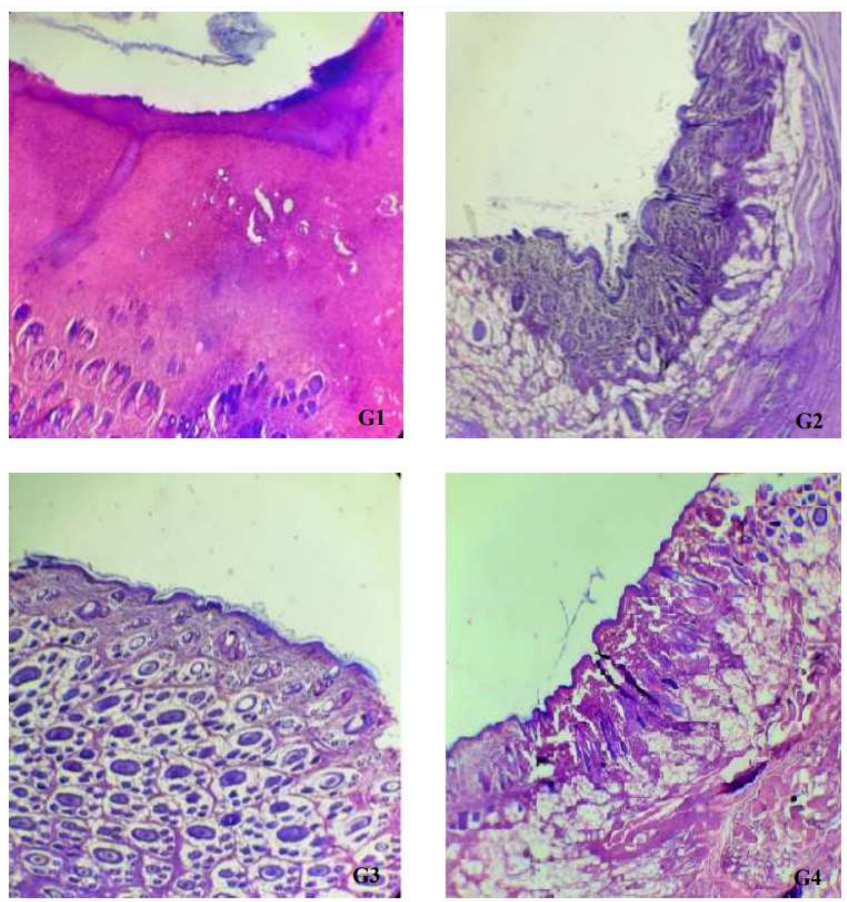
Figure 3 . Regression curve of the wounded area on the days of measurement for each treatment. G1—MEBO containing 0.25% of β-sitosterol; G2—negative control; G3—white petrolatum (vehicle); and G4— E. spinosissimus methanolic extract ointment (MEO).